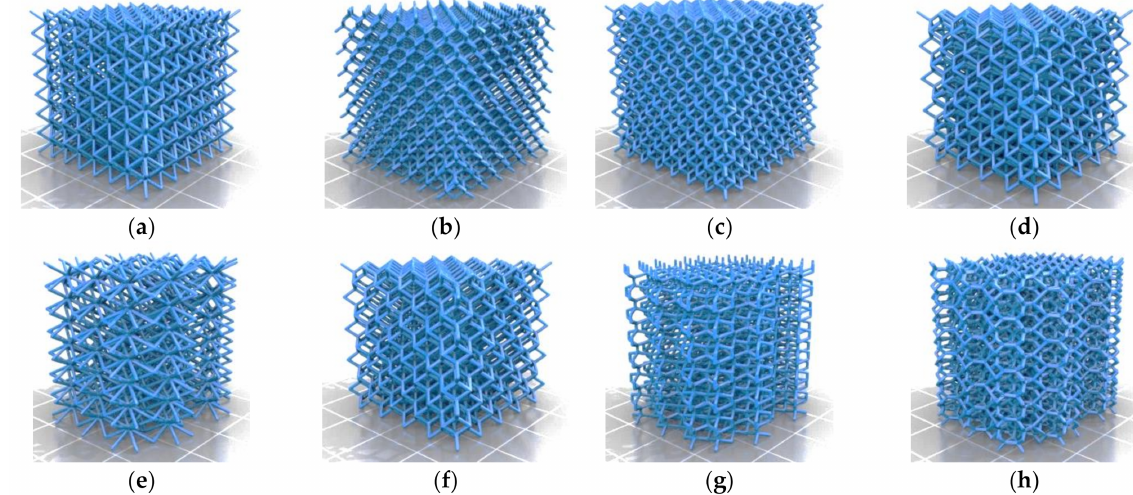
Figure 1. Benchmark of eight lattice structures proposed by Zhou [18]: ( a ) cube vertex centroid; ( b ) cubic diamond; ( c ) cubic fluorid; ( d ) tet vertex centroid; ( e ) hex prism vertex; ( f ) tet oct vertex centroid; ( g ) hex prism diamond; ( h ) hex prism laves phase. Images licensed under the Creative Commons License [19].